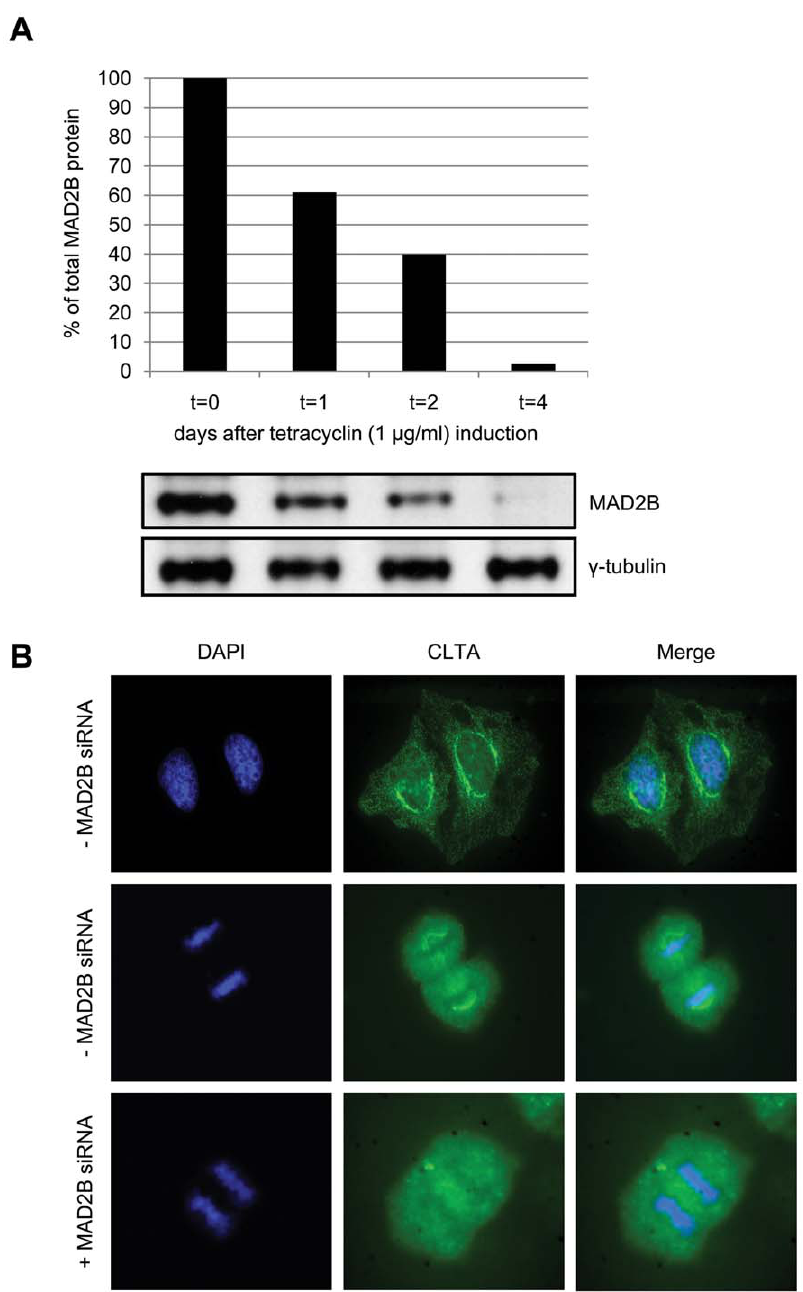
Figure 3. Cellular re-distribution of CLTA after MAD2B knockdown. (A) HEK293/T-REx cells were stably transfected with a pSUPERIOR- MAD2B siRNA construct (see Materials and methods). Subsequently, tetracyclin was added and cells were collected after 0, 1, 2 and 4 days, lysed and subjected to western blot analysis using anti-MAD2B and anti- c -tubulin (control) antibodies. (B) HEK293/T-REx/pSUPERIOR-MAD2B cells were grown with or without tetracyclin ( + / 2 MAD2B siRNA, respectively). Endogenous CLTA proteins were detected using an anti-CLTA antibody (green). DAPI staining (blue) was used to mark nuclei and chromosomes. In the presence of MAD2B CLTA localizes to mitotic spindles during mitosis, whereas after MAD2B depletion CLTA is re-distributed throughout the cell.